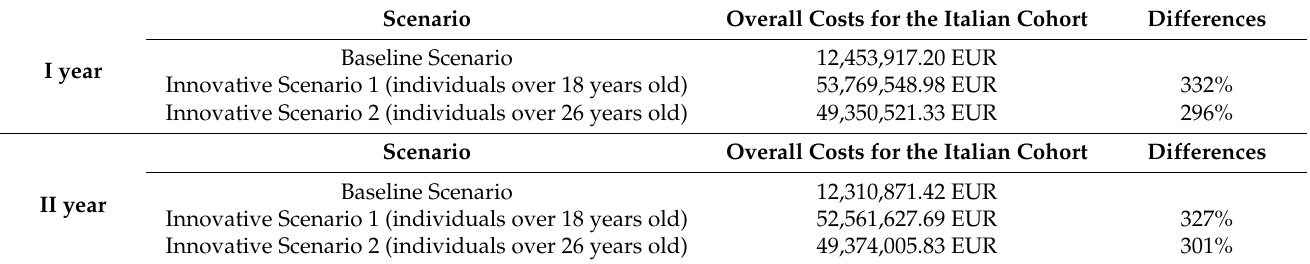
Table 5. Budget impact analysis at the national (Italian) level considering the CAR-T cost of the treatment (with a pay for performance reimbursement approach for the first year after the